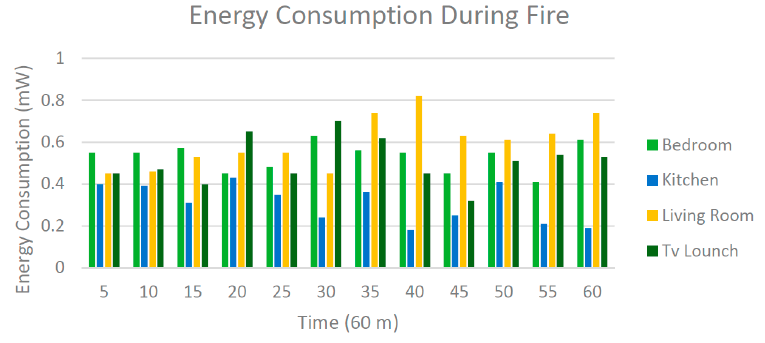
Figure 14. Energy consumption of the sensors during 1 h of fire simulation.